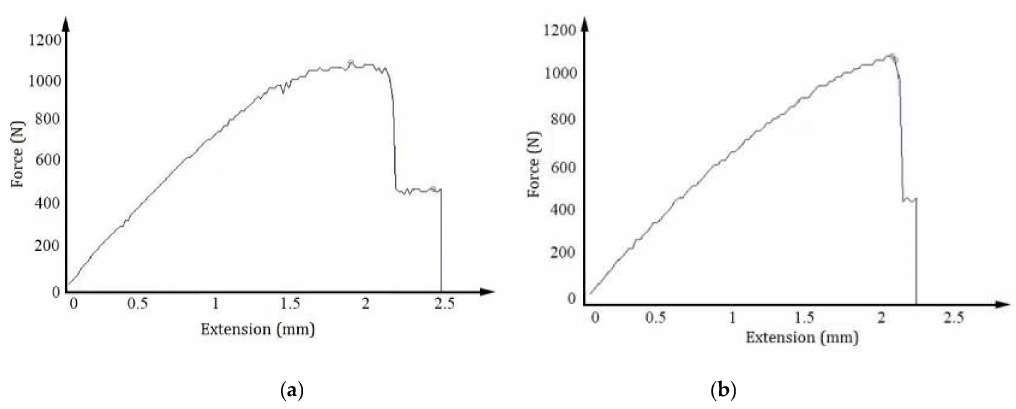
Figure 4. Extension-force diagrams of ( a ) sample #2 and ( b ) sample #4.